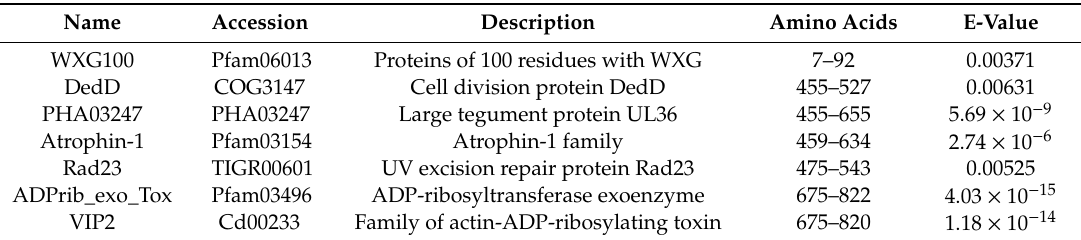
Table 2. Conserved domain analysis of MAV_4644